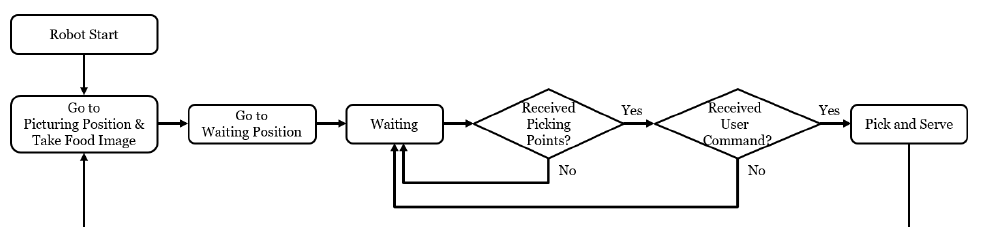
Figure 3. The simple flowchart for the whole meal-assistance